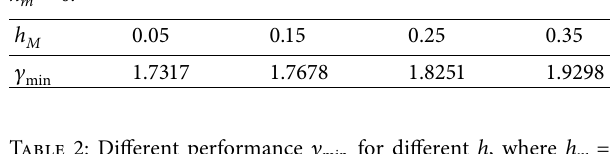
for diferent h , where h m � min